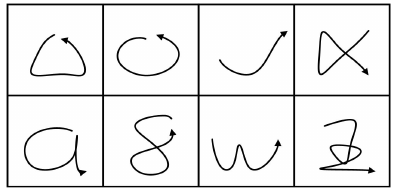
Figure 5 .Gestures Track Samples